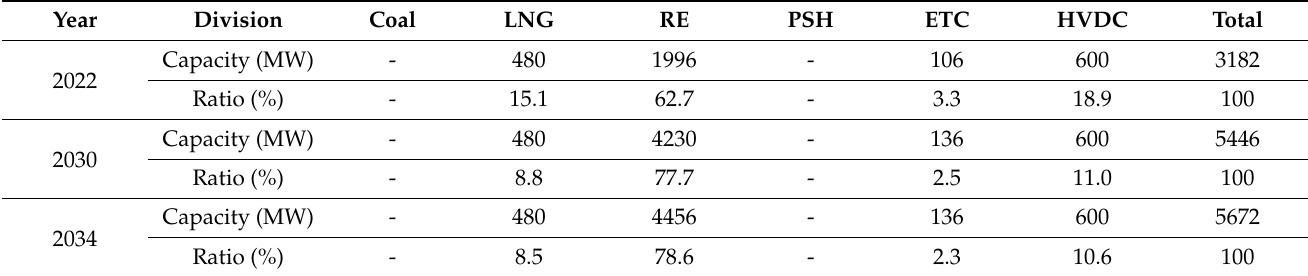
Table 1. The 9th basic plan for long-term electricity supply and demand